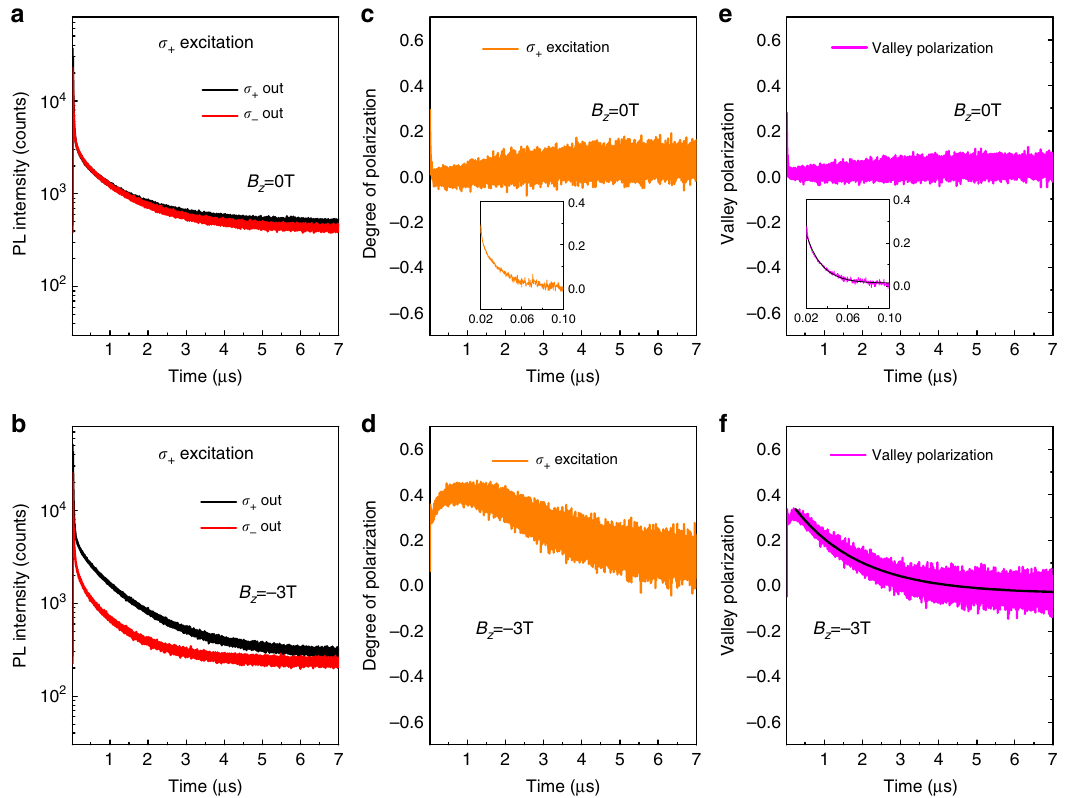
Fig. 3 Time-resolved investigation of polarization in magnetic fi eld. a , b Time-resolved PL of σ + -output and σ − -output pumped by a σ + -polarized pulsed laser in Faraday geometry at B z = 0 T ( a ) and B z = − 3 T ( b ). c , d Degree of polarization extracted from σ + excitation PL at B z = 0 T ( c ) and B z = − 3 T ( d ). e , f Valley polarization calculated from σ + excitation and σ − -excitation PL. The σ − excitation PL data is in the Supplementary Figs. 1 and 2. At B z = 0 T, the degree of polarization disappears quickly and hardly seen after 50 ns and valley polarization has a decay time of 15 ± 0.3 ns. At B z = − 3 T, the difference between σ + output and σ − output is clearly seen even at 200 ns. The valley polarization at B z = − 3 T has a decay time of 1.745 ± 0.007 μ